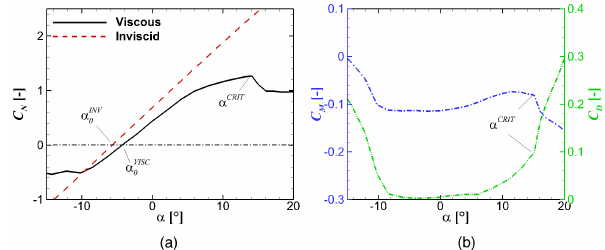
Figure 2. Illustration of the main aerodynamic parameters needed for modeling the dynamic stall